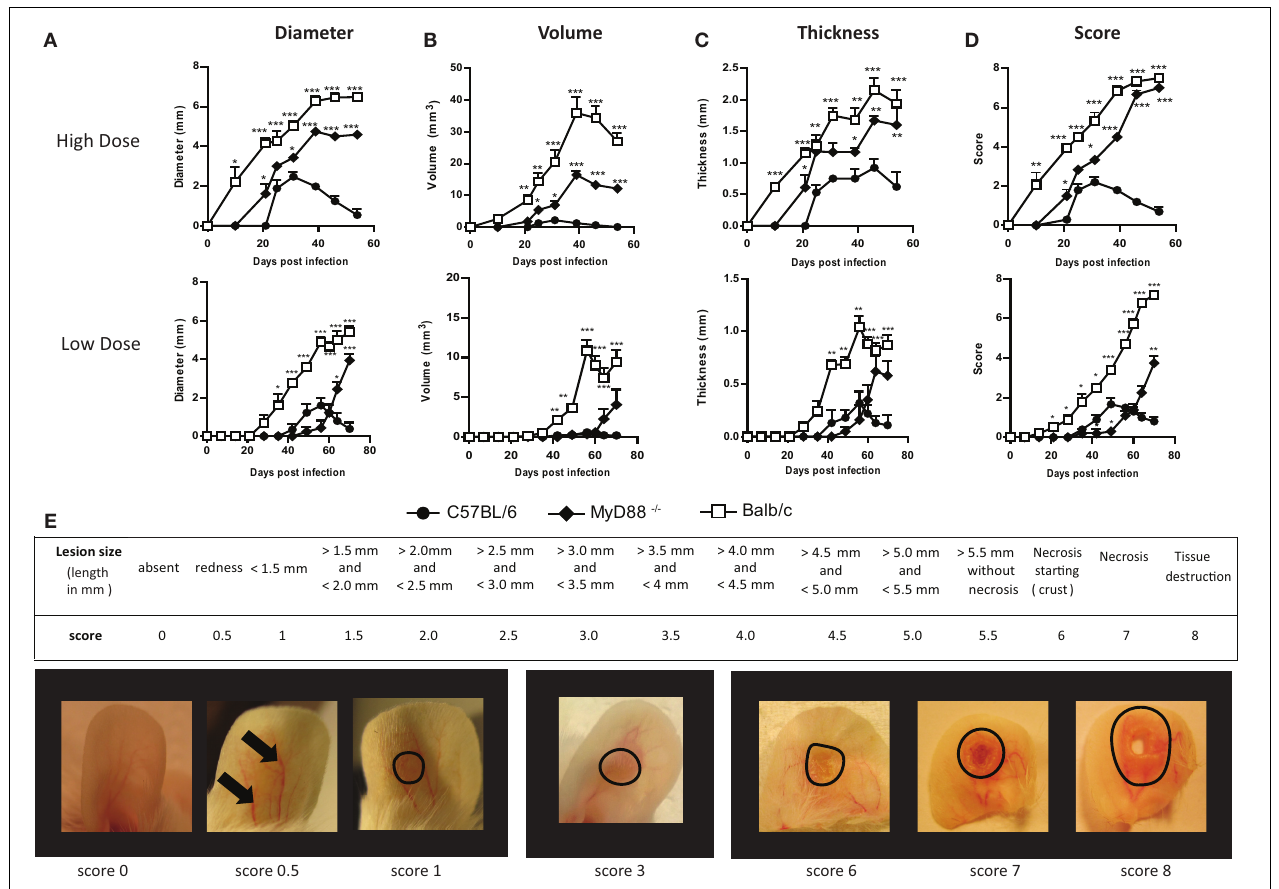
FIGURE 1 | A new scoring system to monitor lesion development of cutaneous leishmaniasis following Leishmania infection in the murine ear dermis. C57BL/6, MyD88 − / − and BALB/c mice were inoculated intradermally in the central ear pinna with 10 μ l of 10 5 stationary phase Leishmania major promastigotes (high dose) or 10 3 metacyclic promastigotes (low dose). Throughout the infection, lesion size was monitored and the results were expressed using the different methods: (A) Diameter; (B)